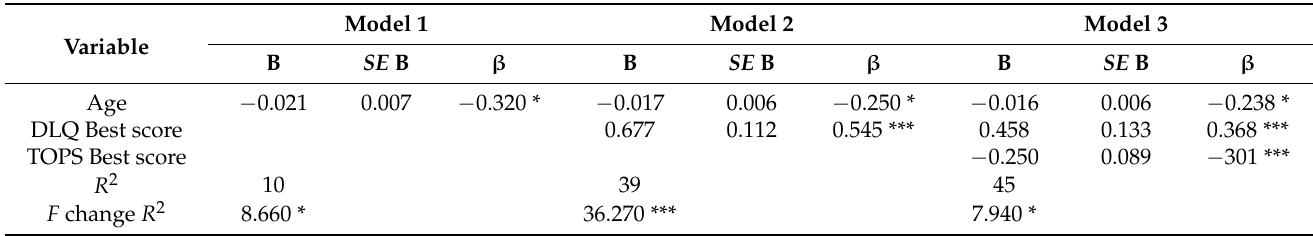
Table 5. Stepwise regression of prediction of the MDS-UPDRS cognitive function (CF) feature by age and functional cognition scales (DLQ and